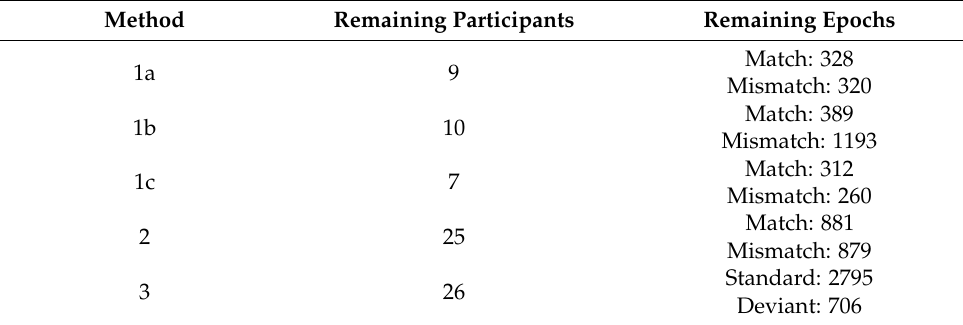
Table 1. Remaining data after